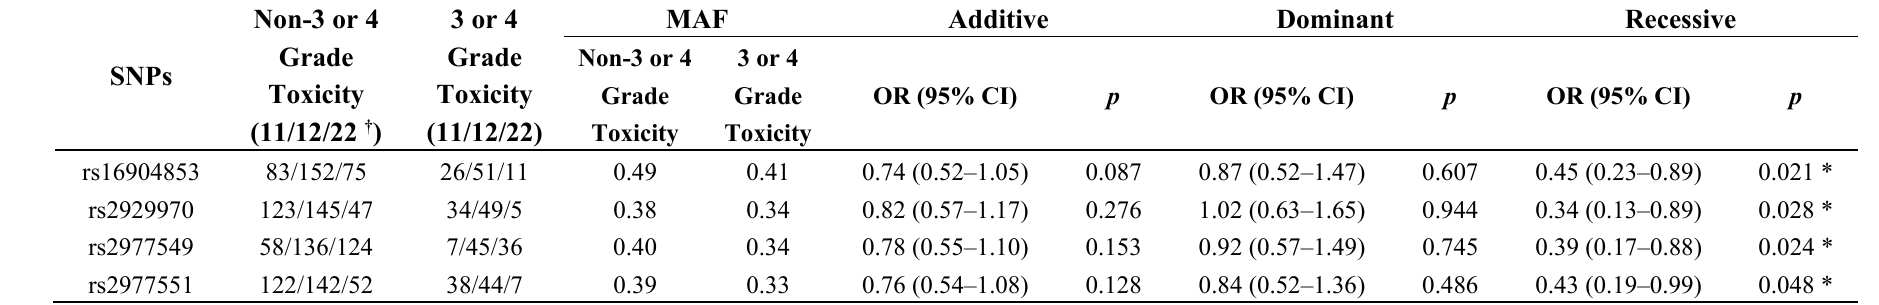
Table 2. Association of rs16904853, rs2929970, rs2977549 and rs2977551 with hematologic toxicity in lung cancer